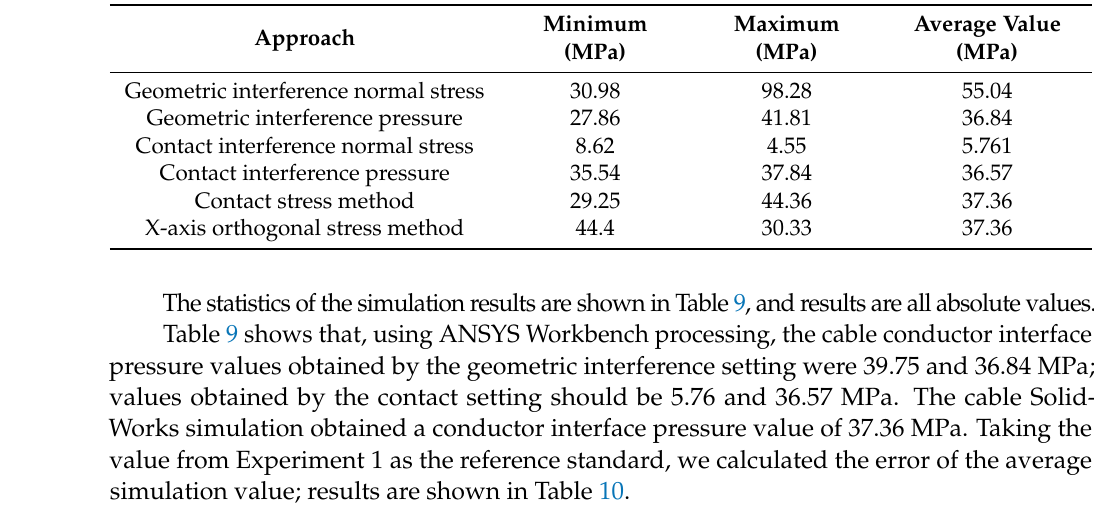
Table 10. Experiment 1 and simulation value error.